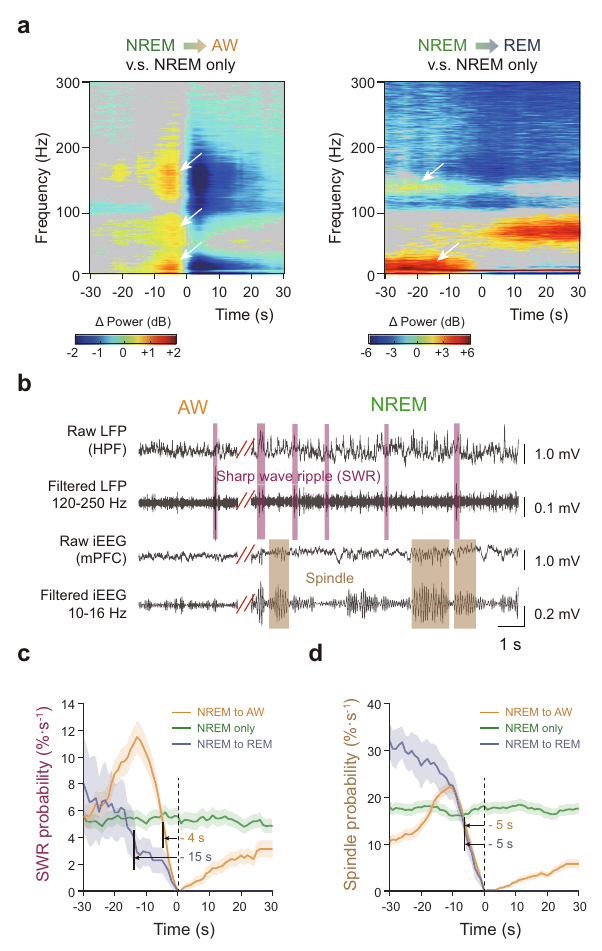
Fig. 6 | Hippocampalinvolvement in statetransitiondynamicsand prediction. a Differences of power spectrograms between “ NREM to AW ” (720 epochs) or “ NREM to REM ” (29 epochs) transition and “ NREM only ” (2521 epochs) state (two- sample t-test, two tails, p <0.05). b Representative trace of sharp wave ripples (SWRs)andspindleevents.Broadband(raw,0.5-512Hz)LFPoriEEGsignaltogether with their band-pass fi ltered (LFP: 120-250Hz, iEEG: 10-16Hz) signals. Purple and brownshadowsrepresentedSWRsandspindleevents,respectively. c , d Signi fi c ant decrease of SWRs ( c ) and spindle ( d ) probabilities per second prior to state tran- sitions, compared to “ NREM only ” state (two-sample t -test, left tail, p <0.05). Colored numbers, the earliest time of signi fi cantly lower event probabilities. Color lines(orshadows),mean(+/ − SEM.)eventprobabilities.Sourcedataareprovidedas a Source Data fi